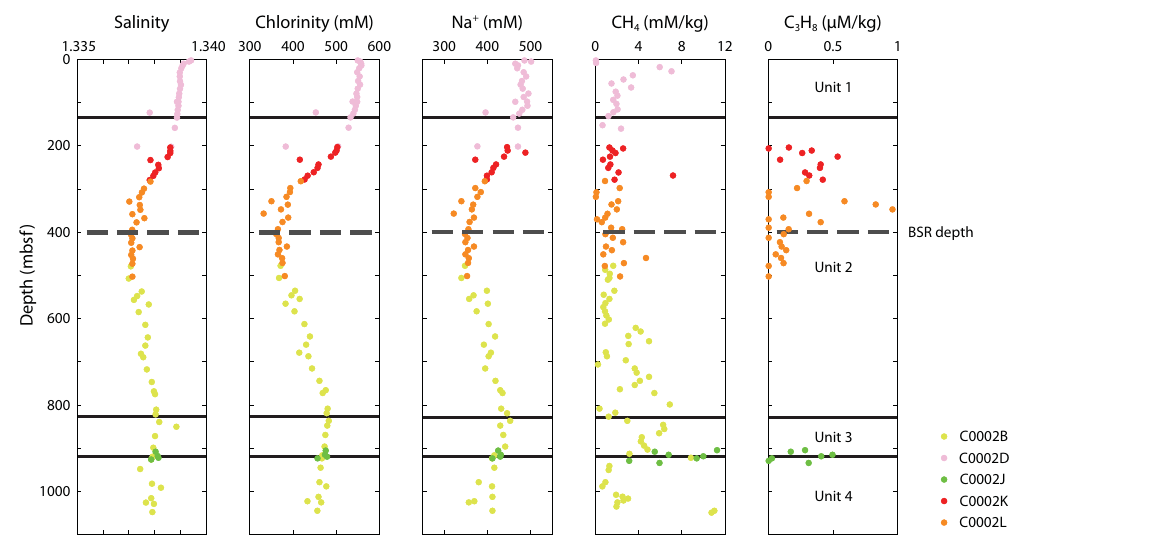
Figure 7. Profiles of salinity, chlorinity, and Na + in interstitial water, and those of methane and propane in headspace gas at Site C0002. Gray dashed line indicates level of BSR for reference. Lithologic unit boundaries are from core interpretations (after Expedition 315 Scientists, 2009; Strasser et al., 2014a).